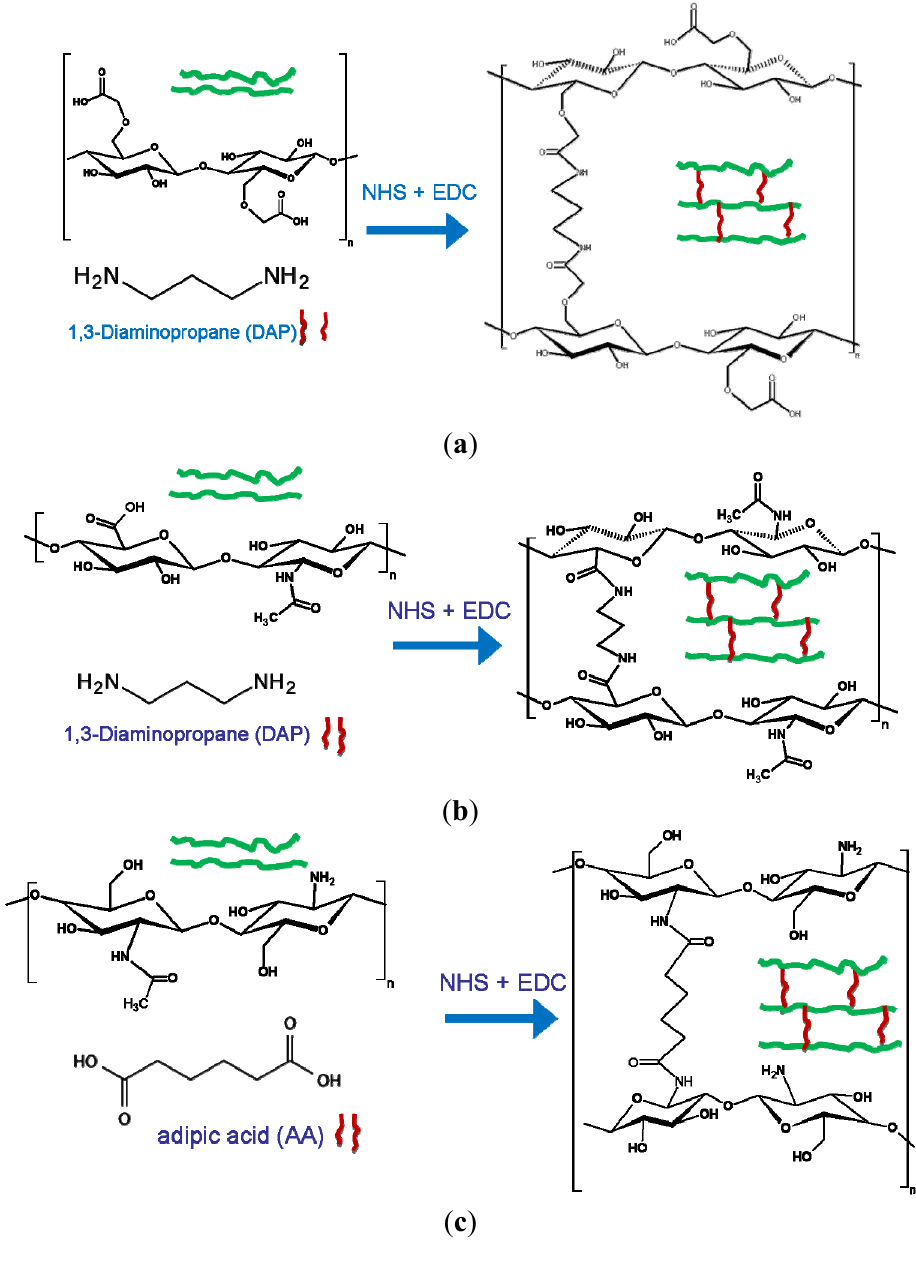
Figure 1. Reaction scheme of ( a ) Carboxy Methyl Cellulose (CMC) hydrogel; ( b ) Hyaluronan (Hyal) hydrogel; and ( c ) Chitosan (CHT)